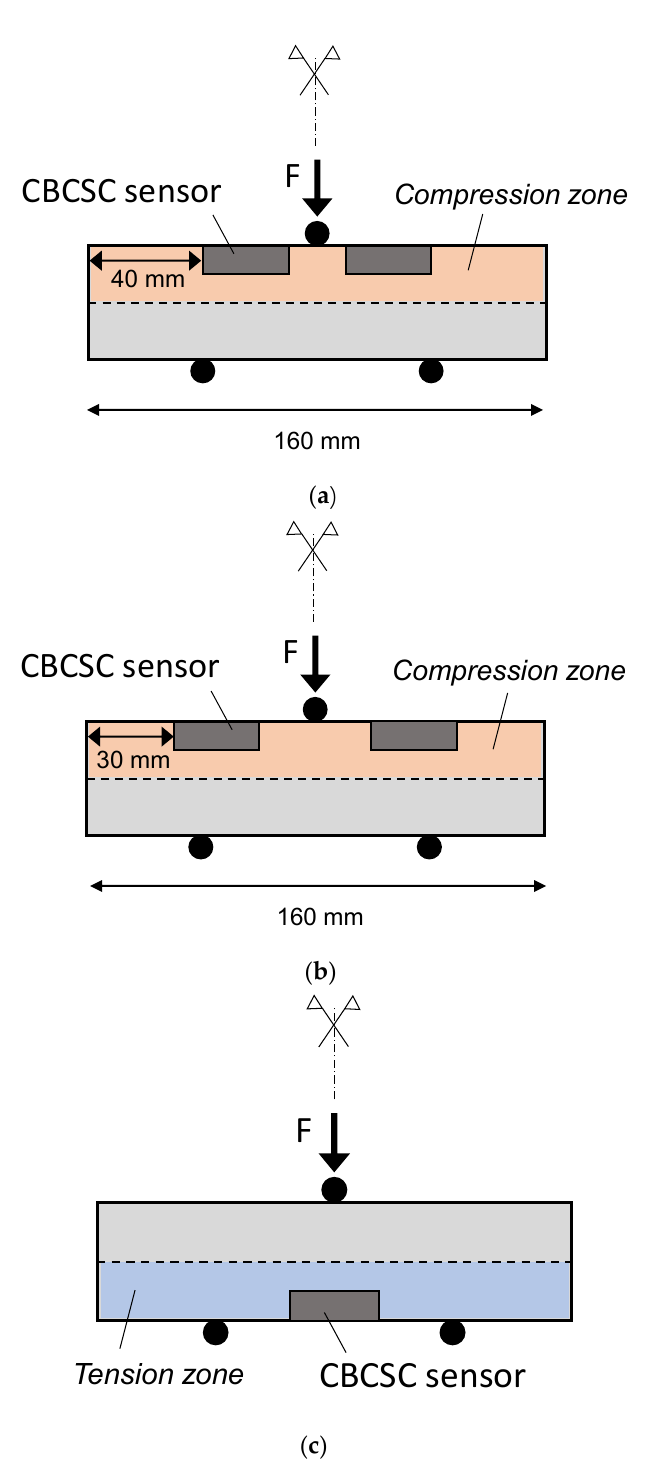
Figure 3. Layouts of CBCSC sensors: Configuration I ( a ), II ( b ), and III ( c ) (adapted from [72]). Roopa and his co-authors [73] carried out experimental tests on reduced-scale beam and column; CSCs doped with different nanocomposite were embedded into those el- ements. Sensors were realized by using three different conducting filler types (MWC- NTs, CFs, and G) combined with each other. Cement mortar matrix was used to ensure proper strength, and w/c ratio equal to 0.45 was assumed. Sensors had dimensions 50 × 50 × 20 mm 3 and were equipped with two electrodes in the central part.